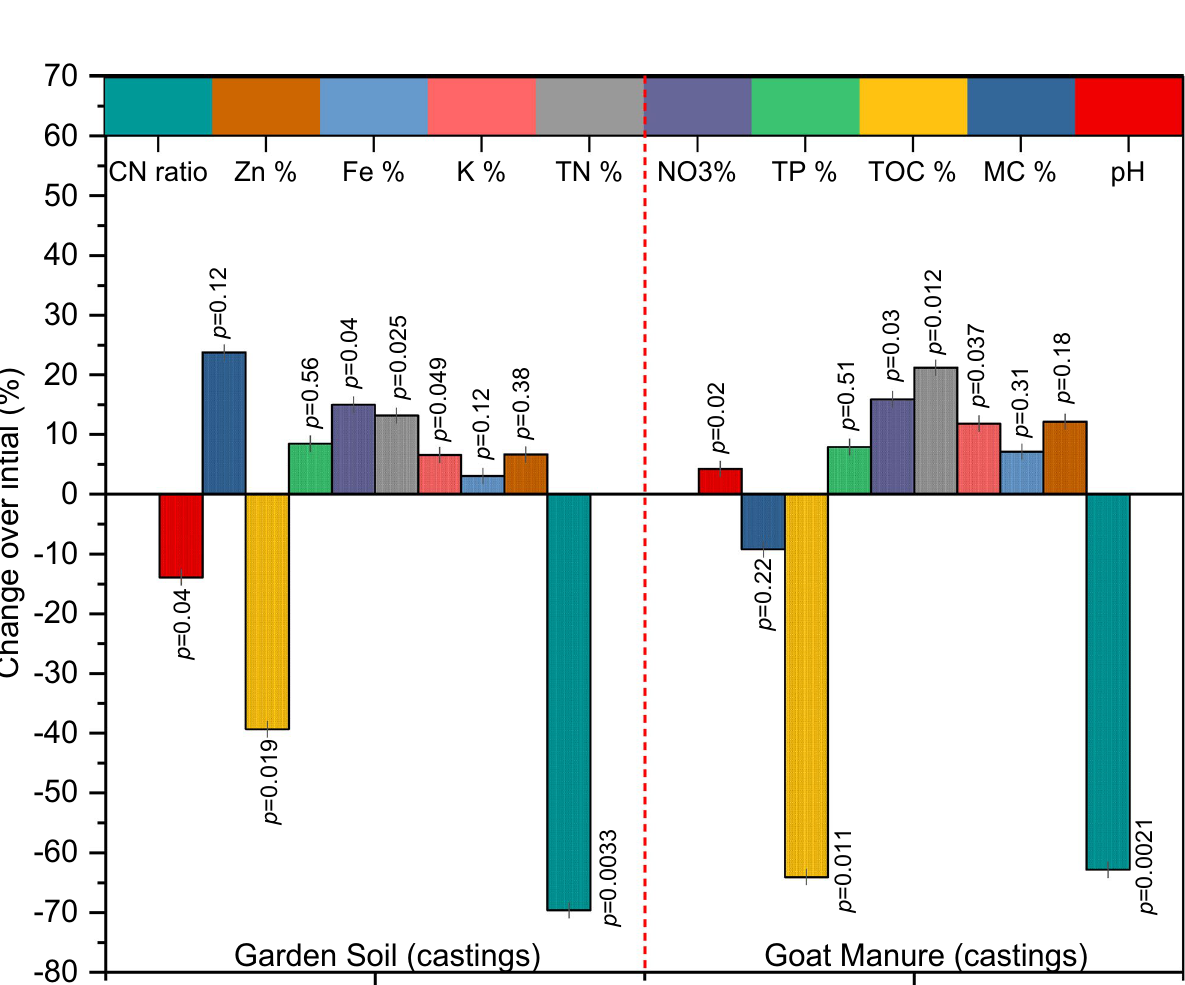
Figure 7. Percent change over initial in the physico-chemical characteristics of vermicompost.